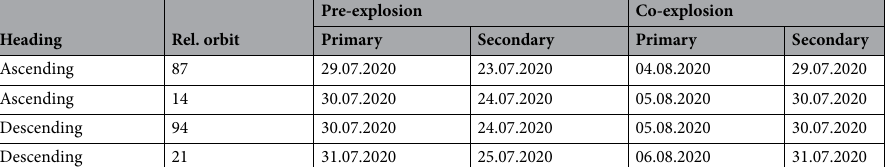
Table 3. Details of the Sentinel-1 data used in the study. Data are acquired in interferometric wide swath mode by Terrain Observation with Progressive Scans (TOPS) in vertical/vertical (VV) polarization. The single look complex SAR images were downloaded from the Copernicus Open Access